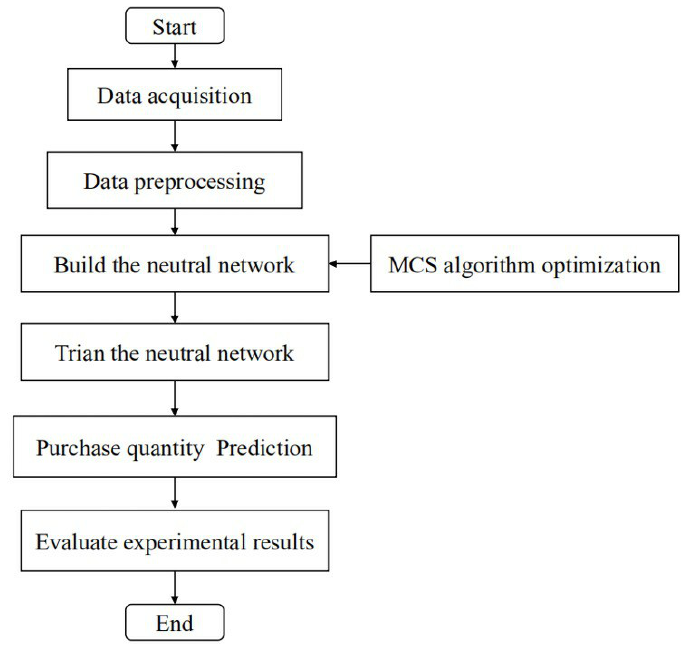
Figure 7. Forecast step diagram.